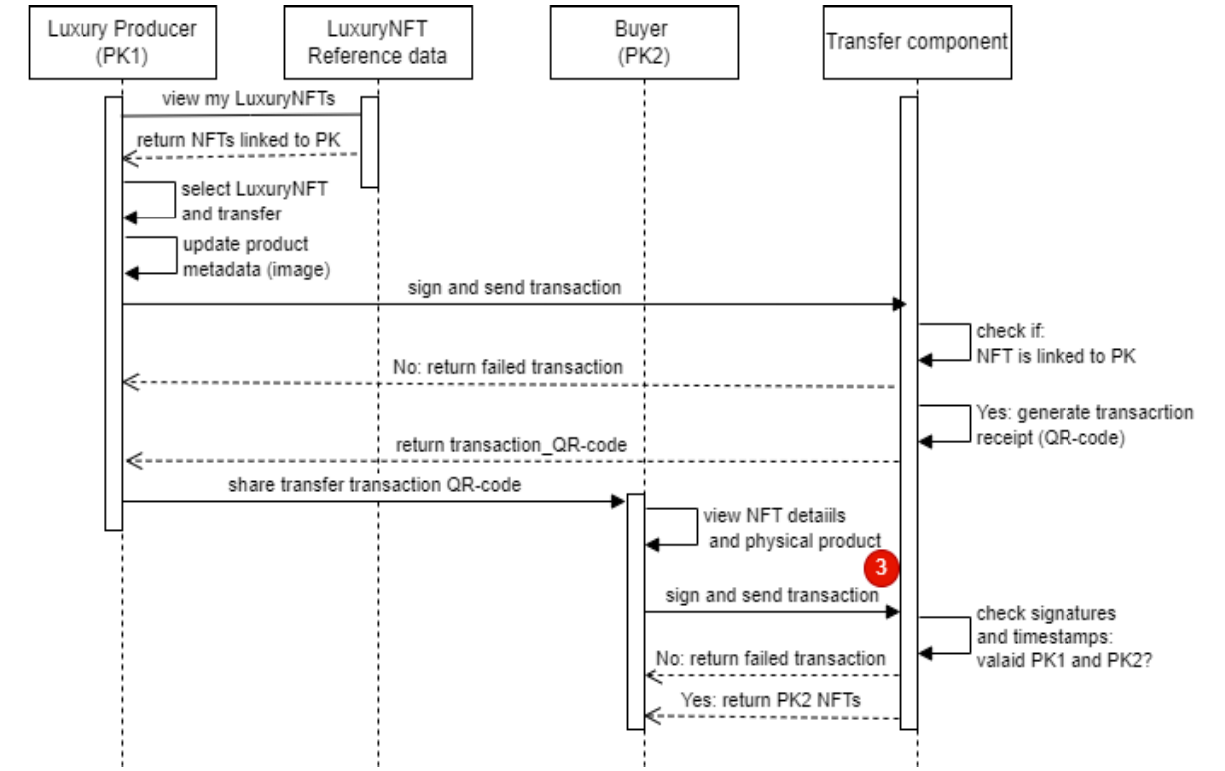
Figure 7. Luxury NFT viewing and transfer sequence.